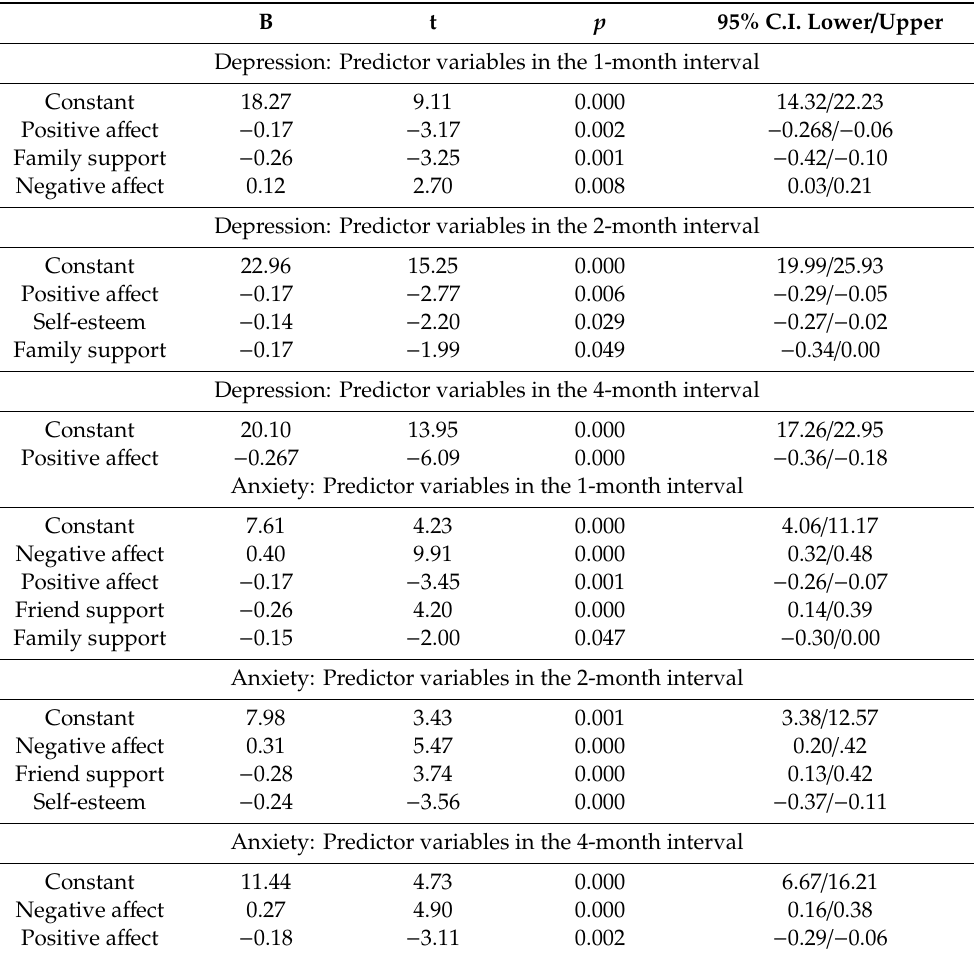
Table 4. Step-by-step multiple regression analyses of depression and anxiety scores in the four time intervals ( n =